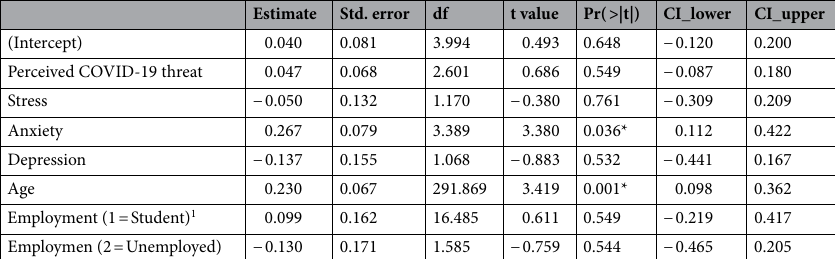
Table 3. Model 3 estimates (DV: Help stranger). 1 Reference class =